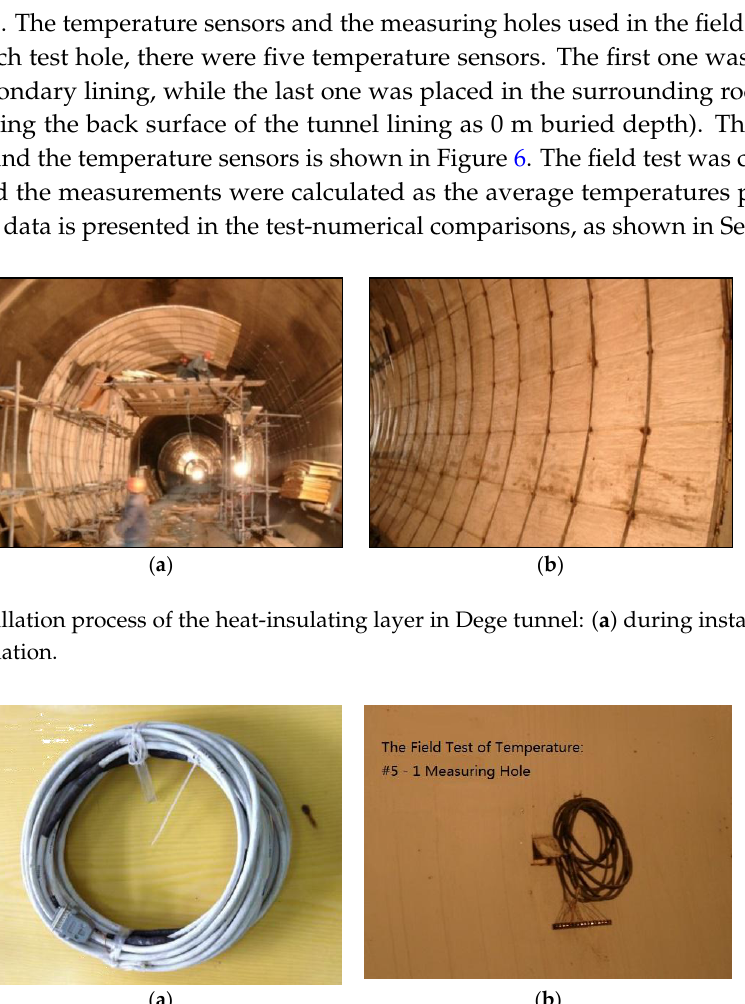
Figure 5. Instrumentations of the field test: ( a ) temperature sensors and ( b ) measuring hole.